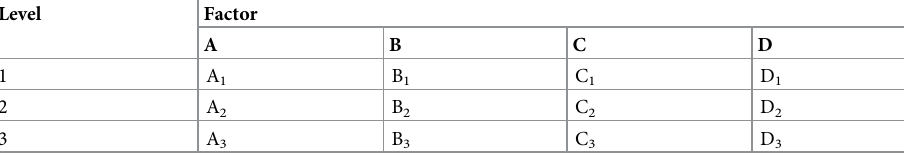
Table 1. Orthogonal table of the four factors considering three levels. Level